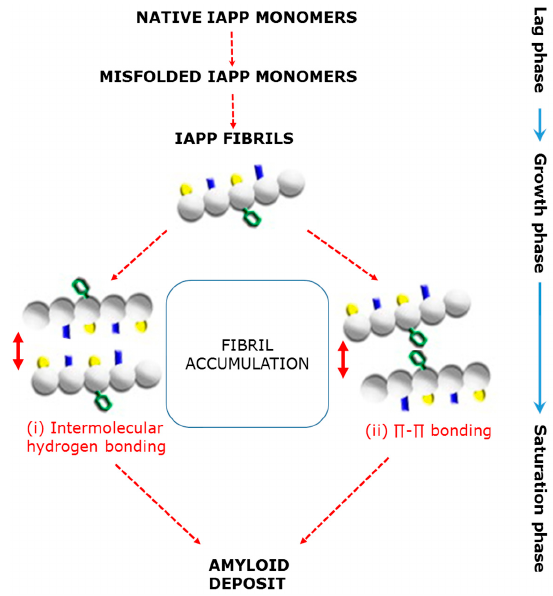
Figure 3. Schematic depiction of the two proposed mechanisms by which IAPP fibrils misfold and aggregate to form amyloidogenic deposits (adapted from [131]).